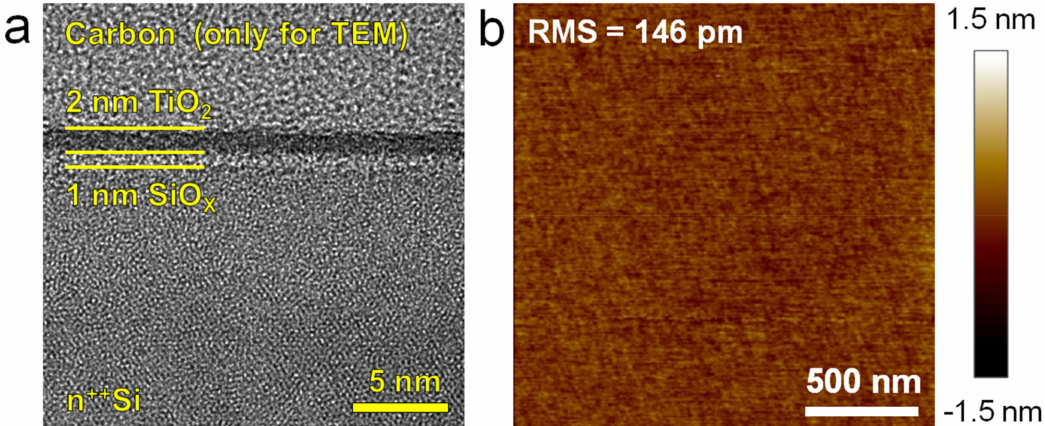
Figure 1. ( a ) Cross sectional transmission electron microscopy (TEM) image and ( b ) atomic force microscopy (AFM) topographic map of a TiO 2 /SiO x /n ++ Si